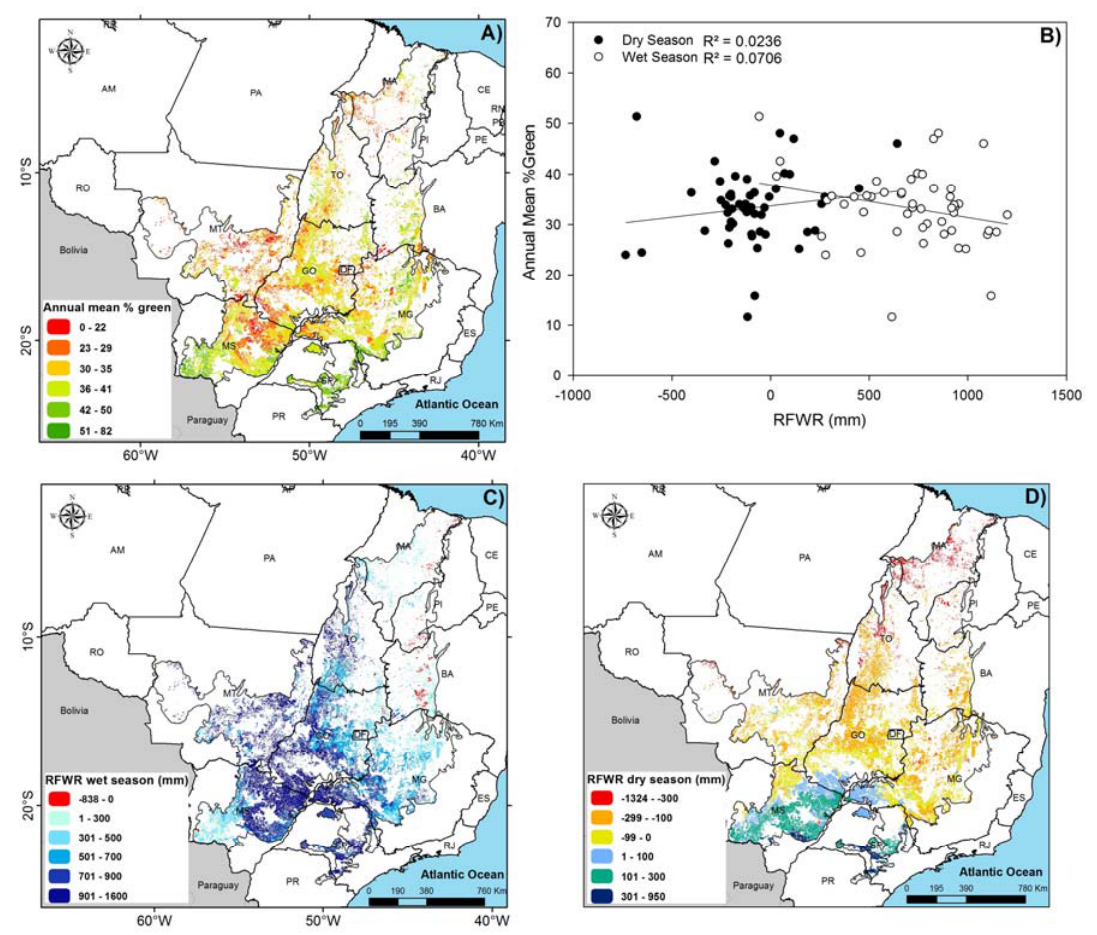
Figure 8. Annual mean greenness values (2009–2010 hydrological cycle) ( A ), relation between dry- and wet-season RFWR and annual mean % green cover ( B ), and accumulated available water for wet ( C ) and dry ( D ) seasons (pasture greenness and RFWR values distributed according to soil and watershed